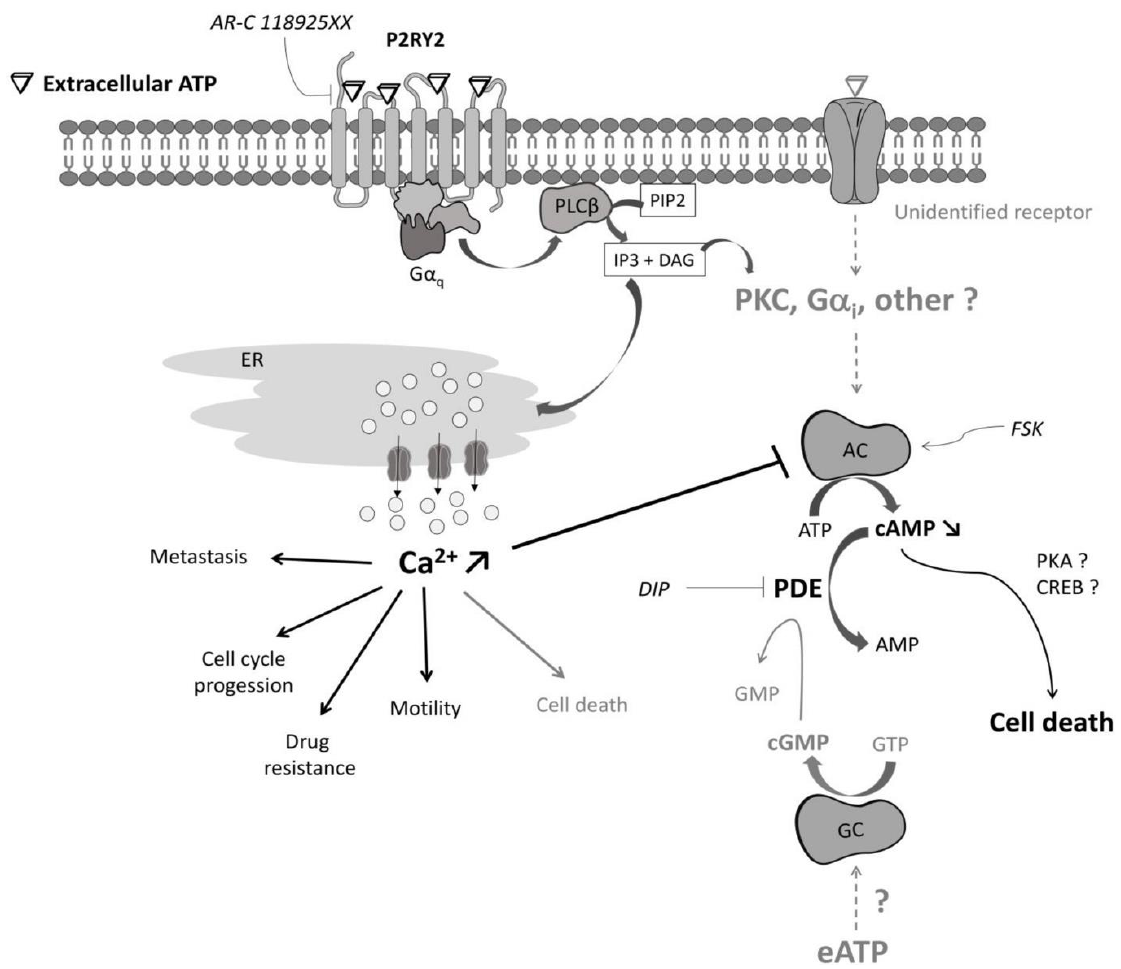
Figure 7. Model depicting how extracellular ATP might affect CRC cell viability. The tri-phosphorylated nucleotides P2Y2 receptor is overexpressed in CRC cells. In the presence of extracellular ATP (eATP), P2RY2 activation induces a rise of cytoplasmic Ca 2+ which is fully abolished by the selective pharmacological inhibitor AR-C 118925XX. For HT29 cells, extracellular ATP, through its binding to P2RY2, phospholipase C activation and Ca 2+ mobilization, leads to adenylyl cyclase (AC) inhibition and cAMP level decrease. Subsequently, the decrease in cAMP levels might impact PKA and/or CREB activities and modulate HT29 cell survival. Both the common activator of adenylyl cyclases, forskolin (FSK), and the non-selective phosphodiesterase (PDE) inhibitor, dipyridamole (DIP), can fully abolish the effects of extracellular ATP on HT29 cells. For HCT116, LS513 or LS174T cells, extracellular ATP also induces a rise of cytoplasmic Ca 2+ through P2RY2 binding. However, Ca 2+ mobilization does not impact cell viability. This suggests that P2RY2 activation might be involved in the modulation of other Ca 2+ -dependent pathways implicated in cancer progression. Besides its binding to P2RY2, extracellular ATP might act on HCT116, LS513 or LS174T cellular viability through its binding to as-yet unidentified purinergic receptors and the subsequent activation of downstream signaling pathways able to modulate adenylyl and/or guanylyl cyclase (GC) activity. DIP, by increasing both cAMP and cGMP levels, can fully abolish the effects of extracellular ATP on HCT116, LS513 and LS174T cell viability.